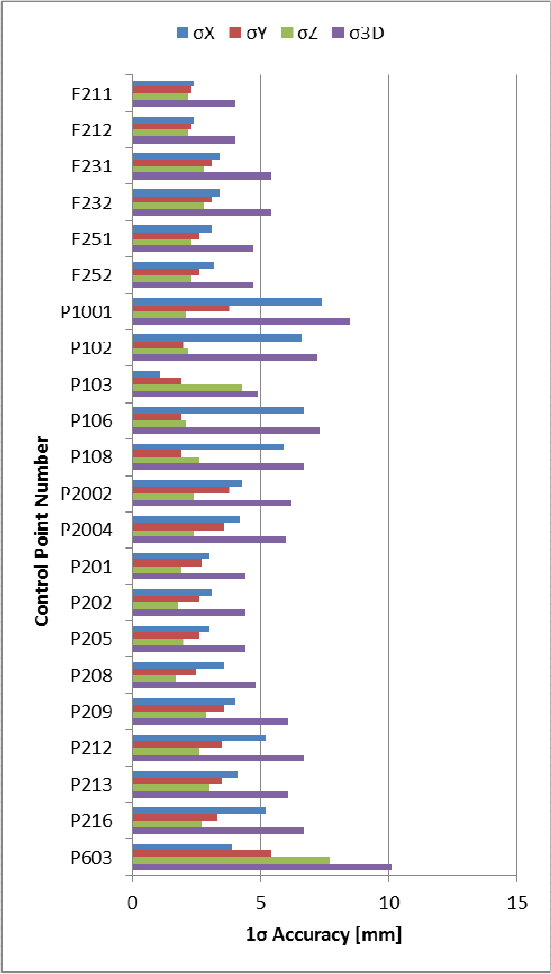
Figure 3. One-sigma accuracy estimates for control points surveyed on the Optech